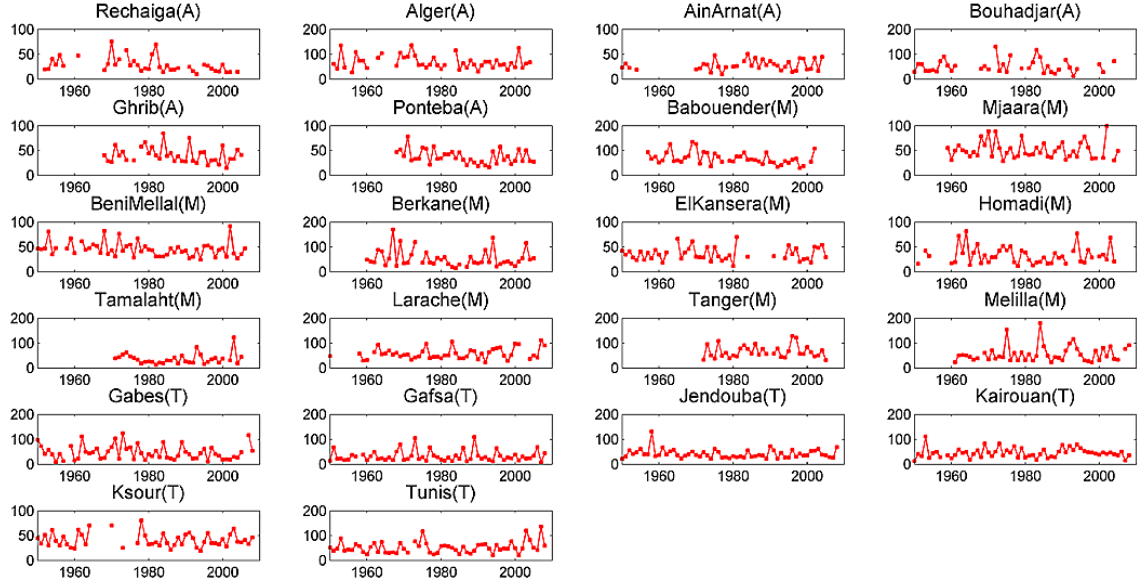
Fig. 8. Times series of the annual maximum daily precipitation (RX1day, in mm) at the different stations.